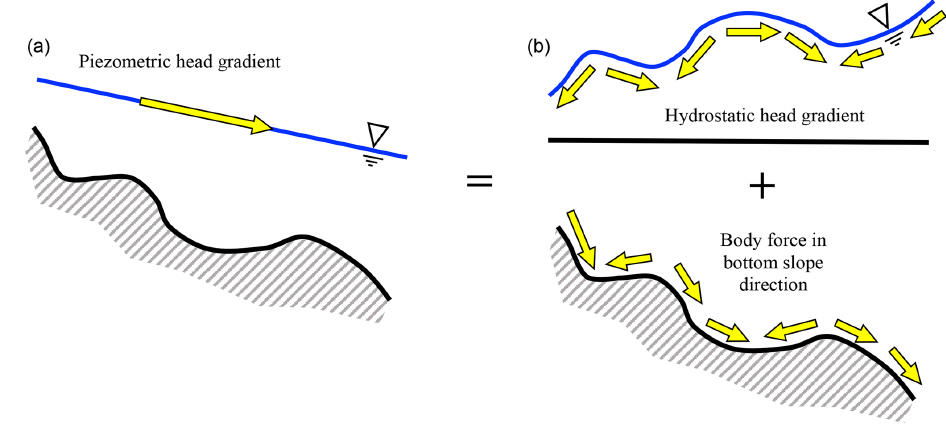
Figure 3. Comparison of Piezometric forcing terms with sharply varying topography for Eqs. (1) and (2). (a) The Piezometric head gradient for Eq. (1). (b) The equivalent split form of forcing from Eq. (2) using the identity of Eq. (3). The variability of the bottom of (a) will be reflected in the cross-section area, A(x) , that feeds back into the solution of η(x) . In contrast, (b) attempts to directly represent topographic variability as both a driving term in S 0 (x) and a solution response term, h 0